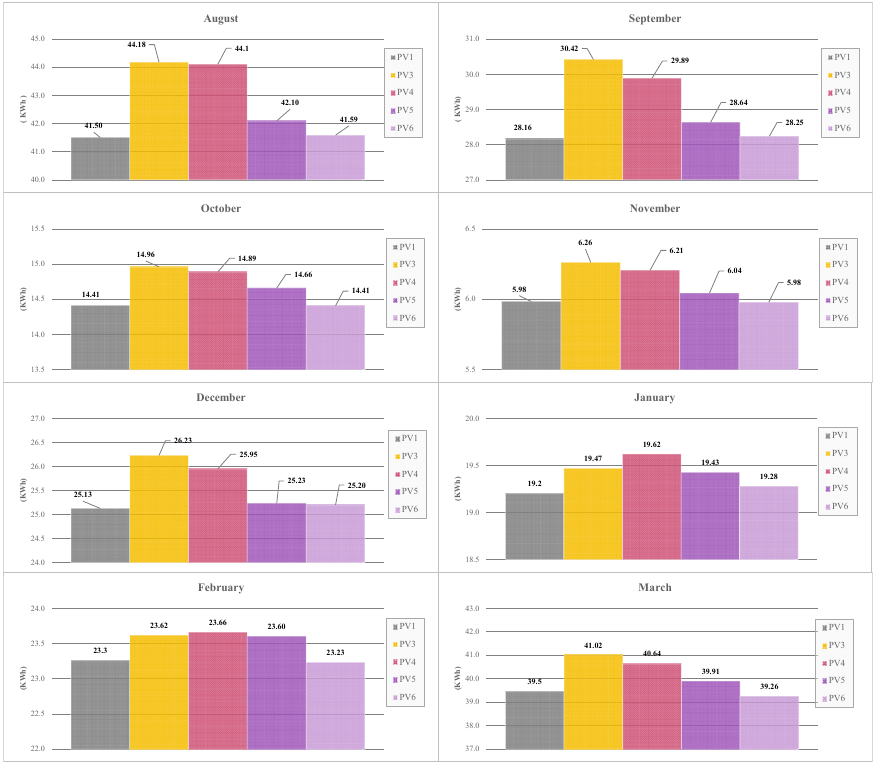
Figure 7. Monthly energy production of the reference module and the four PV modules equipped with the cooling sys- tems. Finally, the total energy produced by the six modules is reported in Figure 8.